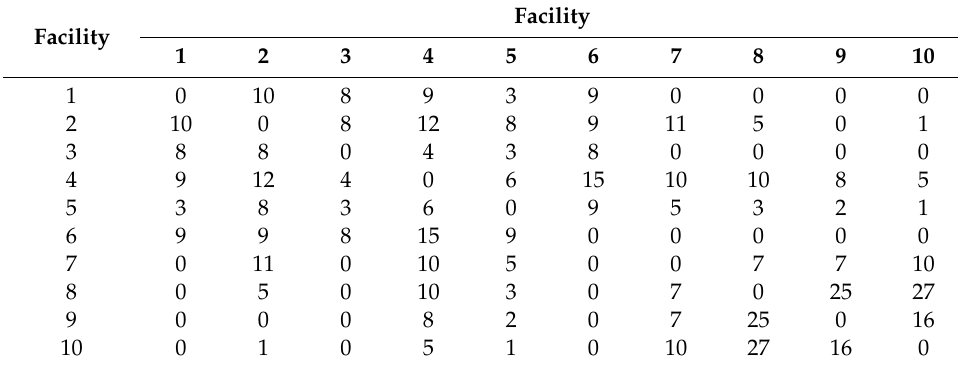
Table 7. Frequencies of trips between facilities.